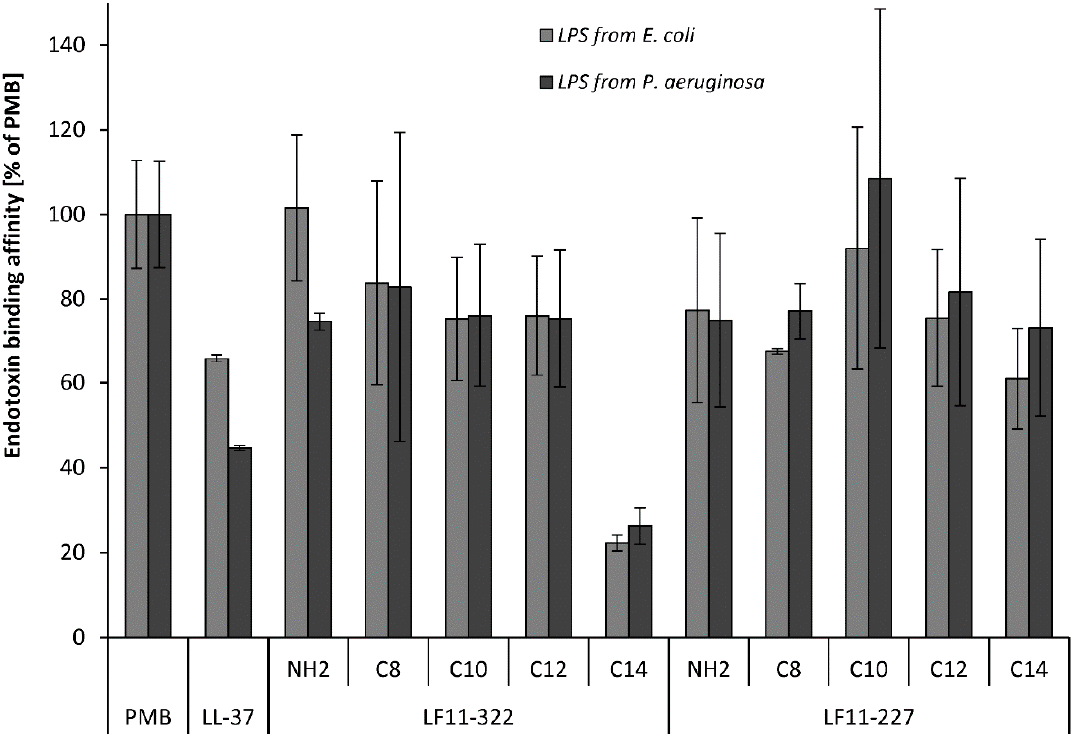
Figure 1. Endotoxin binding affinity of various antimicrobial peptides determined by a fluorescence based displacement method using Bodipy Cadaverine [20] in aqueous solution. Data are given in the percent of the binding affinity of Polymyxin B ( n = 3).